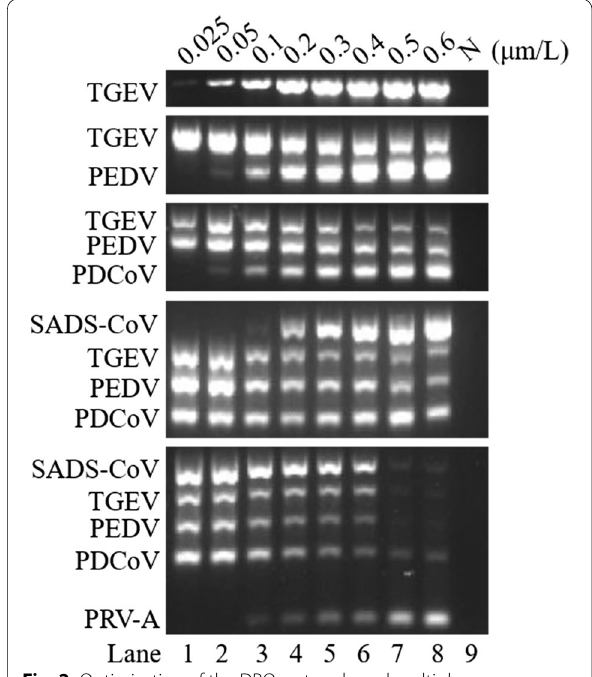
Fig. 2 Optimization of the DPO system-based multiplex RT-PCR primer concentration. Lanes 1–8 represent the 8 primer